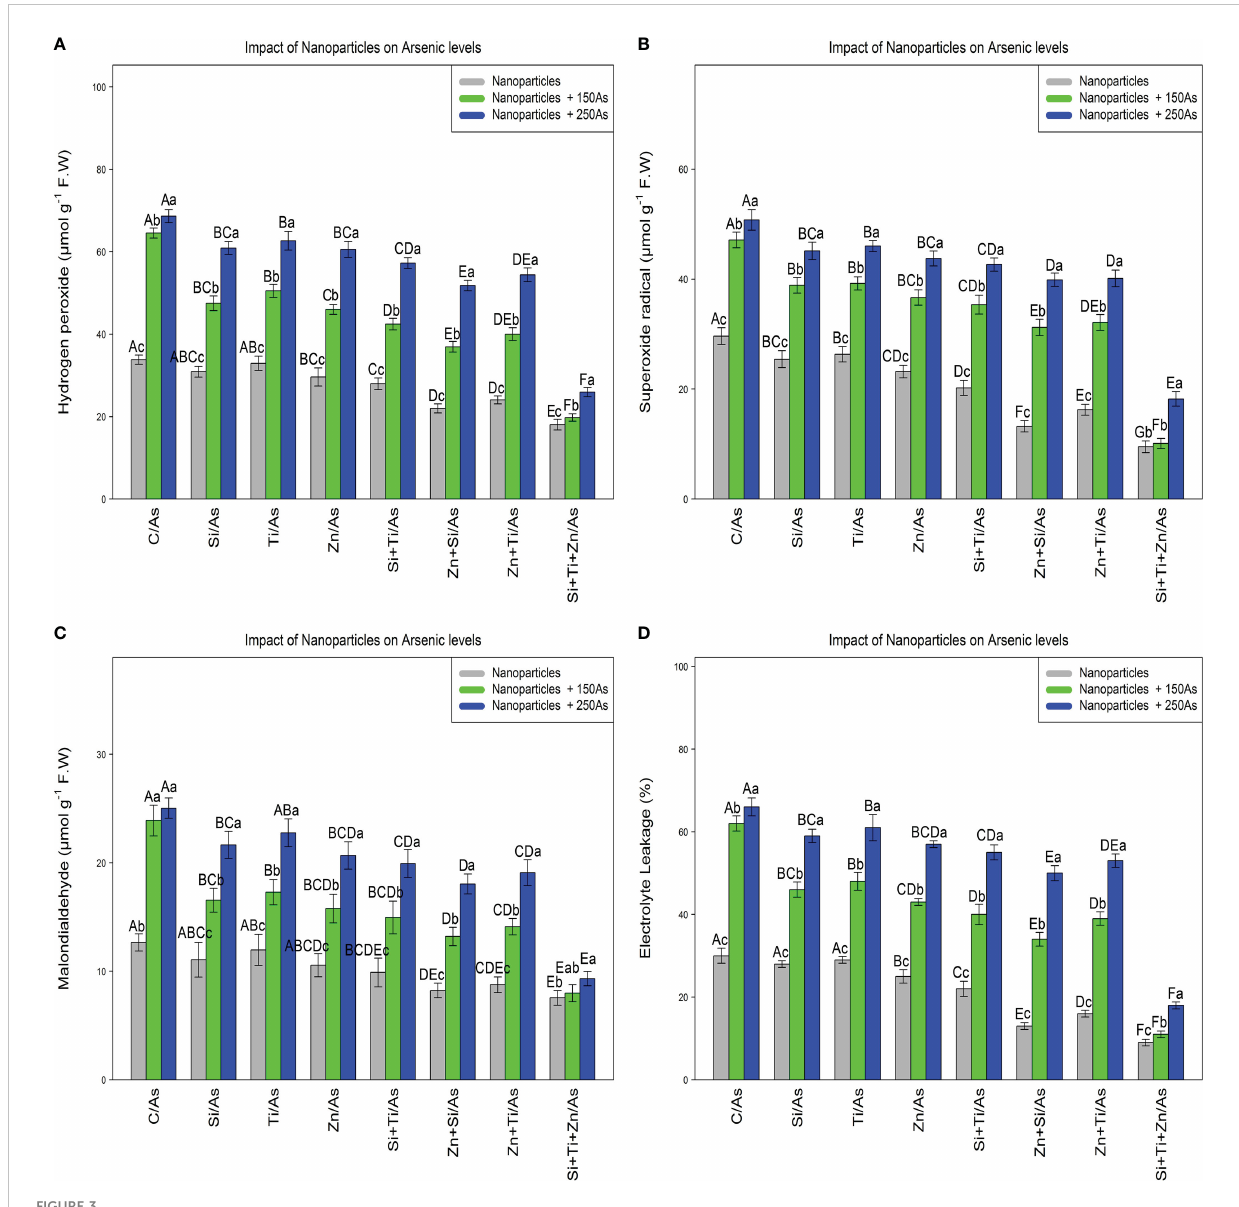
FIGURE 3 The impact of NPs alone and in combination on hydrogen peroxide (A) , superoxide radical (B) , malondialdehyde (C) , and electrolyte leakage (D) in one-year-old Pleioblastus pygmaeus exposed to 150 and 250 µM As (four replicates). In this fi gure, the letters a, b, c, etc. indicated signi fi cant differences following the application of NPs with 150 and 250 µM As based on Tukey ′ s test (p<